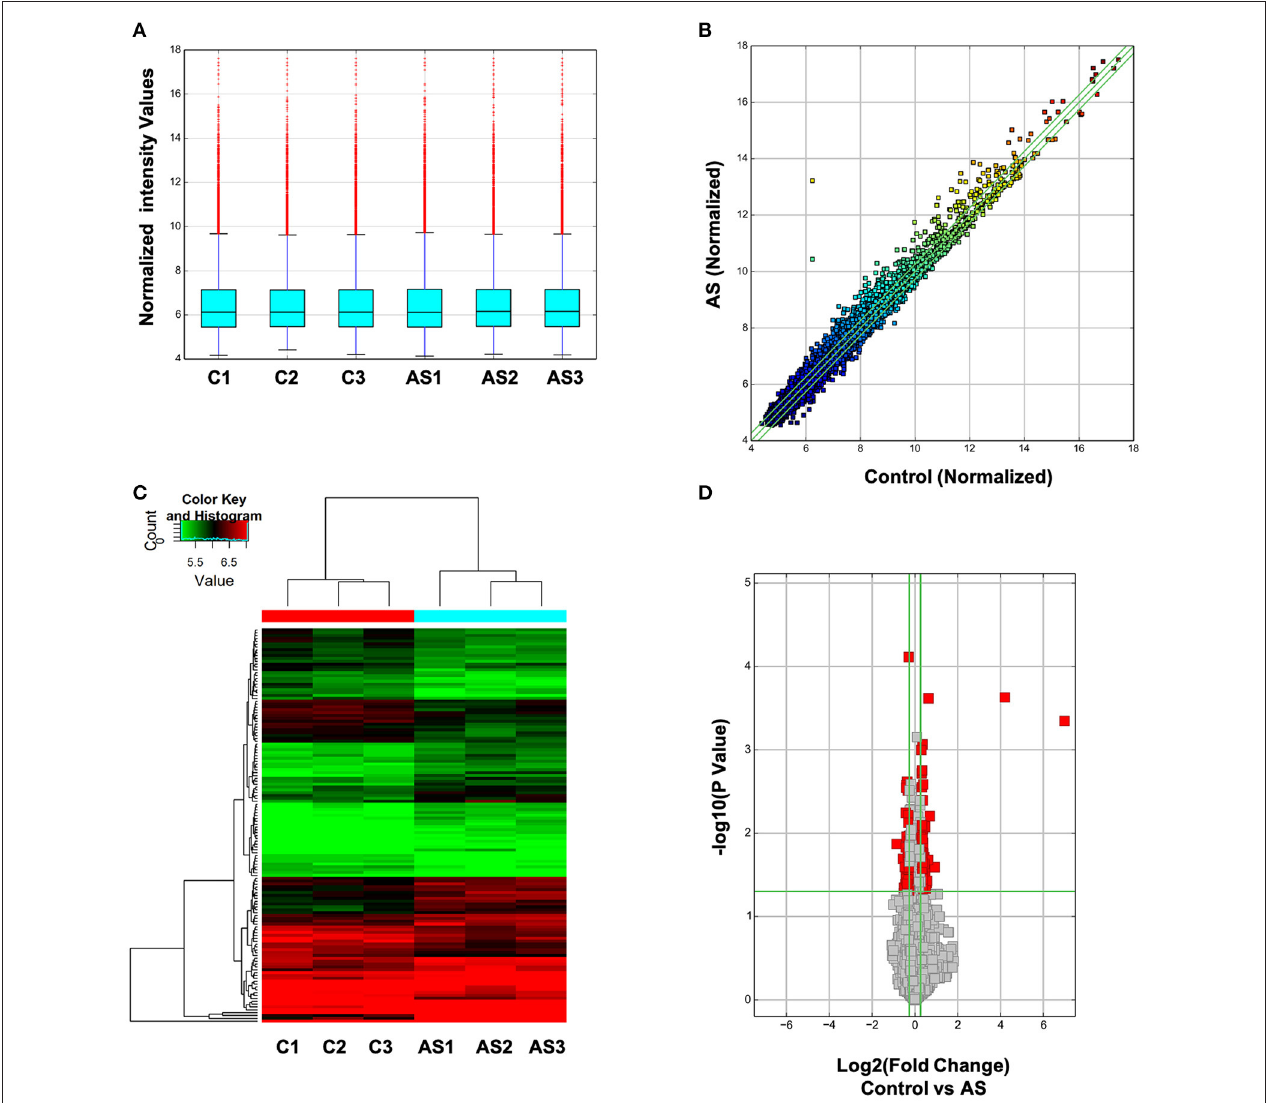
FIGURE 2 | Expression spectrum of circRNAs was screened and analyzed by Arraystar circRNA Microarray Chip. (A) Data standardization. (B) The overall distribution of chip data. The horizontal and vertical axes represent circRNA expression of different samples respectively. The closer the data get to the center diagonal, the closer the circRNA expressed in two group; while the farther away the data get to the center diagonal, the greater the difference in circRNA expression level between two samples. (C) Cluster analysis of differentially expressed circRNA in each sample. Red represents high expressed circRNAs and green represents low expressed circRNAs. (D) Differentially expressed circRNA with statistically significant difference between control and AS group.